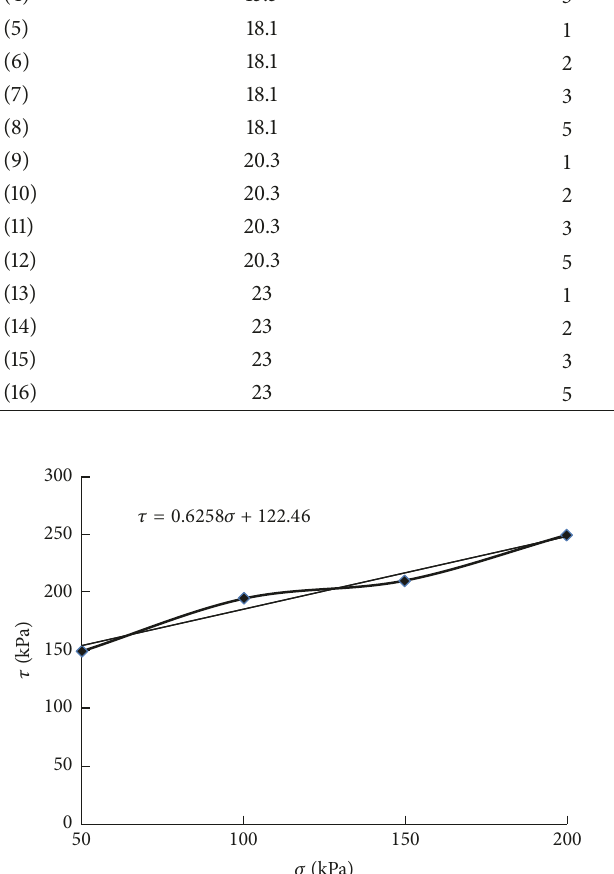
Figure 5: Mechanical parameters fitting results.